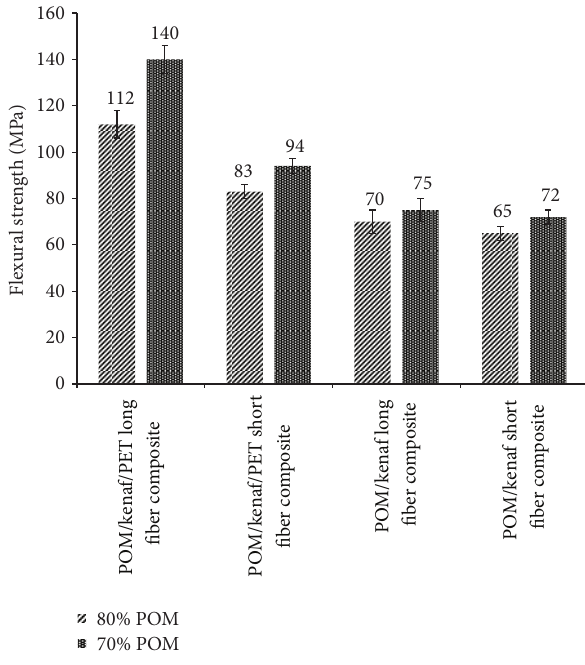
Figure 6: FESEM micrograph of the hybrid composite of (a) weath- ered samples and (b) controlled samples. Figure 7: Flexural strength of controlled samples.